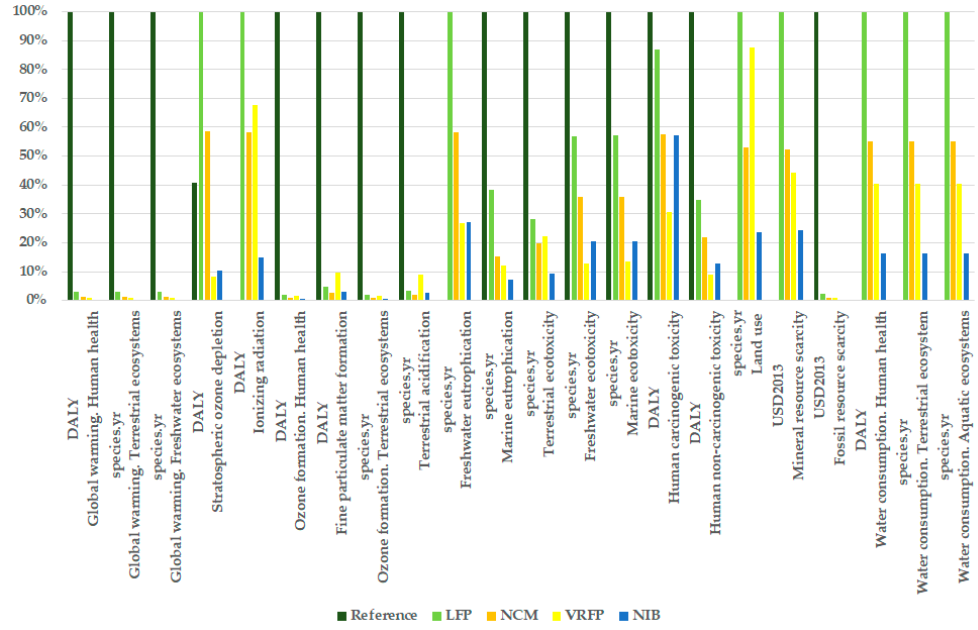
Figure 3. Impact characterization for the different batteries and of the reference case (ReCiPe 2016 method-Endpoint (H)).